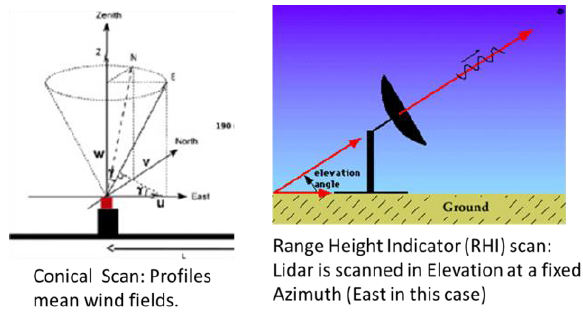
Fig. 2 Conception of Lidar Scan Strategies